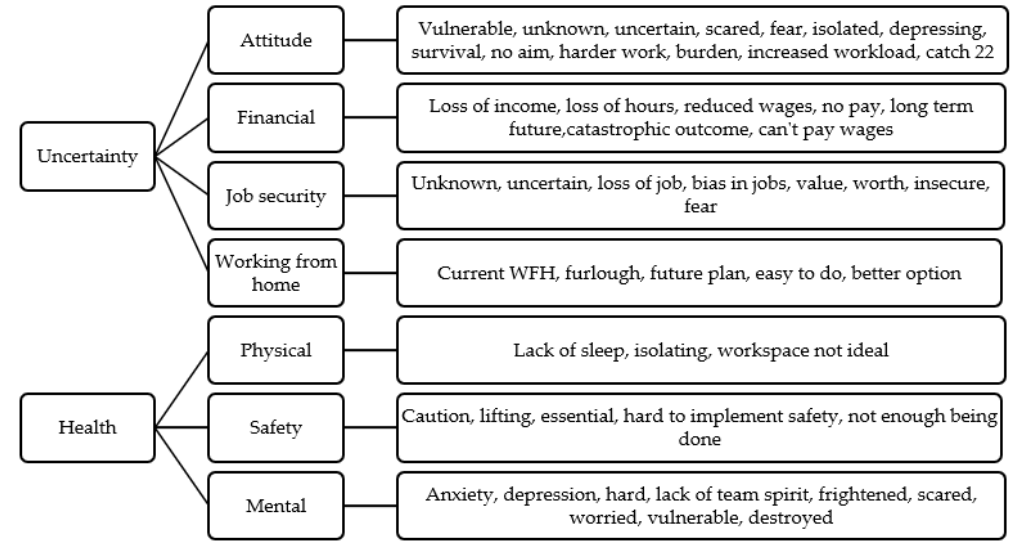
Figure 2. Further impacts of COVID-19 on staff (key themes).